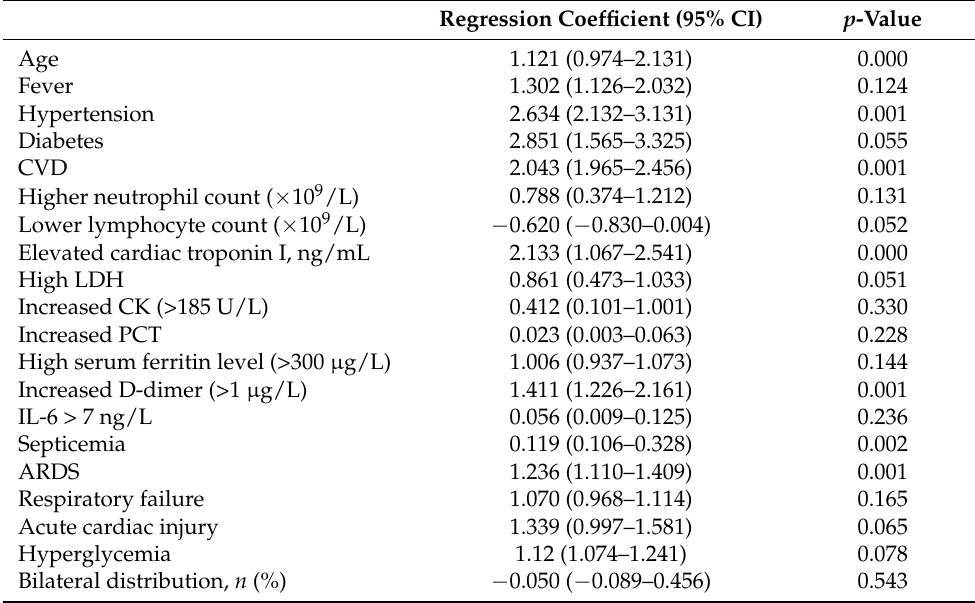
Table 4. Multivariate analysis of risk factors associated with COVID-19